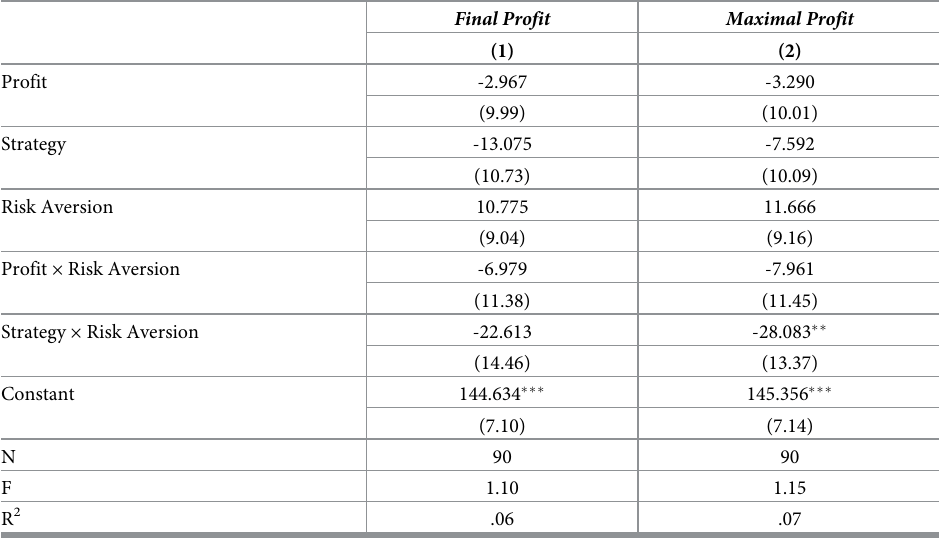
Table 1. Heterogeneous treatment effect. OLS regression with robust standard errors (HC3) in parentheses. The out- come variable is the final profit (column (1)) and the maximal profit (column (2)), both representing exploratory behavior. Risk Aversion is the subject-specific degree of risk aversion. Level of significance: � p < .1; �� p < .05; ��� p <